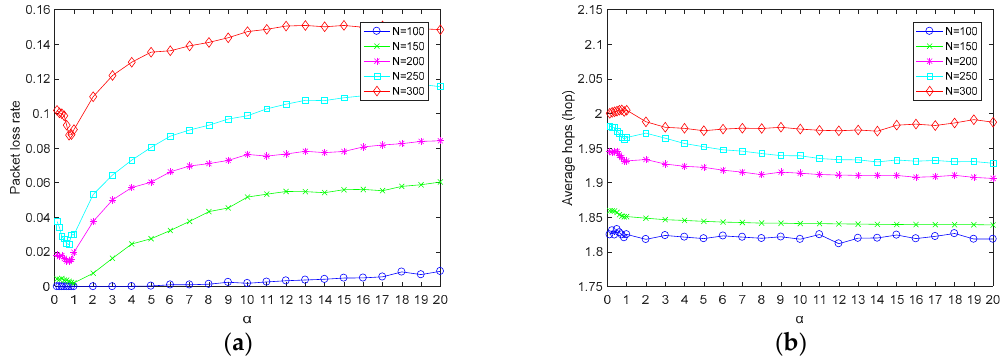
Figure 3. ( a ) Impacts of α on packet loss rate (PLR); ( b ) Impacts of α on average hops